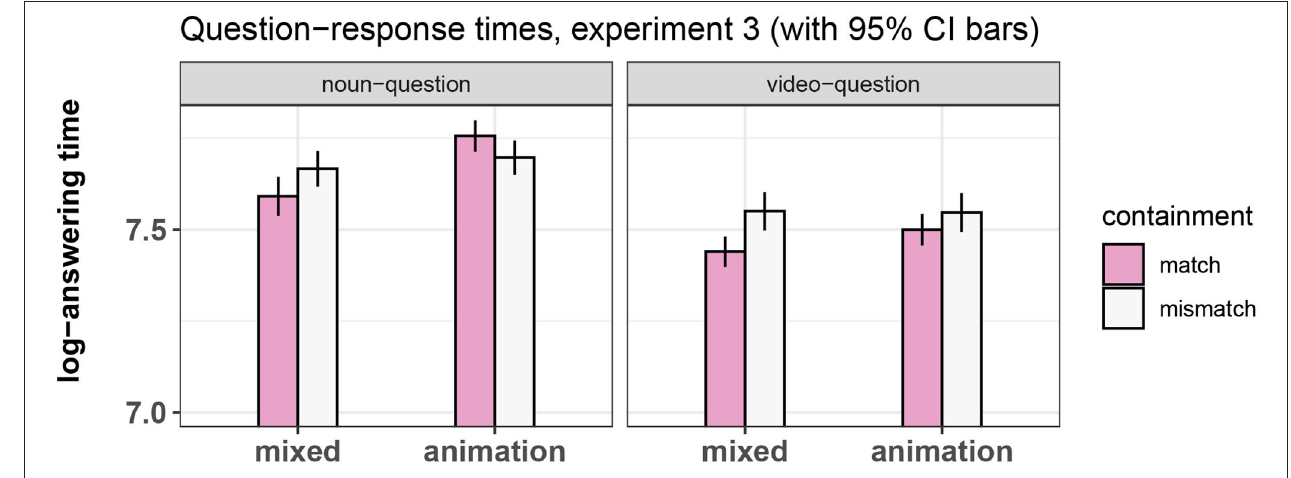
FIGURE 11 | Summary of results for the question response time, Experiment 3.